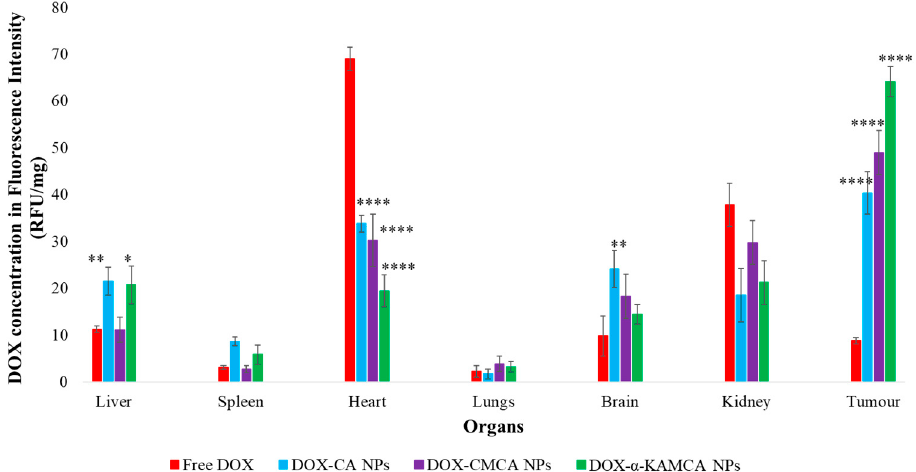
Figure 7. Biodistribution of free DOX, DOX-loaded CA NPs, DOX-loaded CMCA NPs, and DOX-loaded α -KAMCA NPs in the 4T1 murine breast cancer cell line-induced tumor mouse model at 2 h of treatment. Values were significant (*) at a p -value of 0.01 to 0.05, very significant (**) at a p -value of 0.001 to 0.01, and extremely significant (****) at a p -value < 0.0001 vs. the same treatment with free DOX at a CI of 95%.